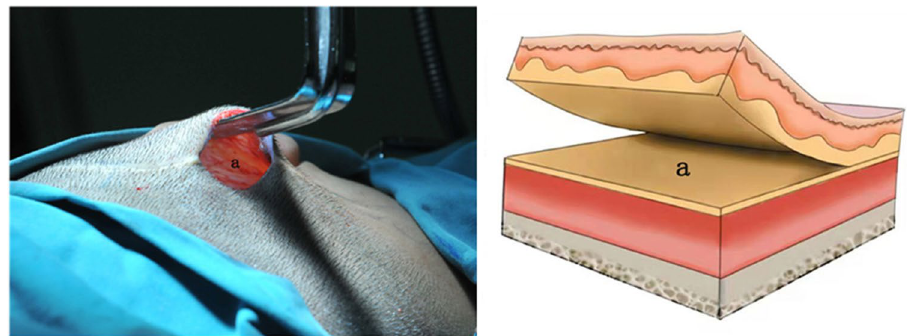
Figure 1. Schematic diagram of the dissection layers in the conventional surgical procedure. a: The superficial fascial